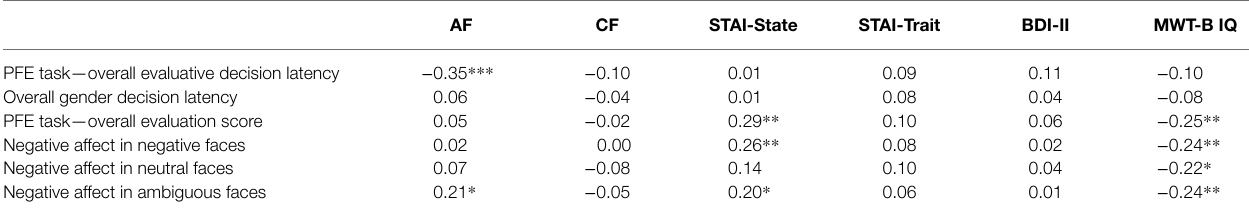
TABLE 2 | Correlations of psychometric measures with performance in the PFE task (overall evaluative decision latency, overall evaluation score, and bias scores) and the gender decision task (overall gender decision latency; N =